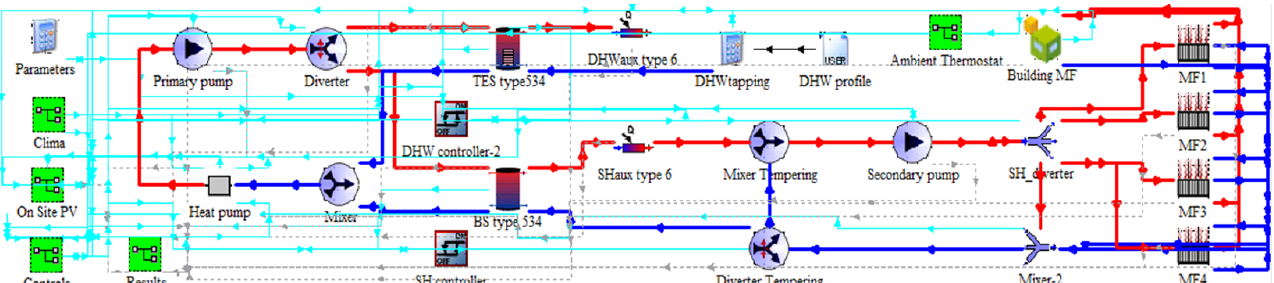
Figure 4. Layout of the developed TRNSYS model.